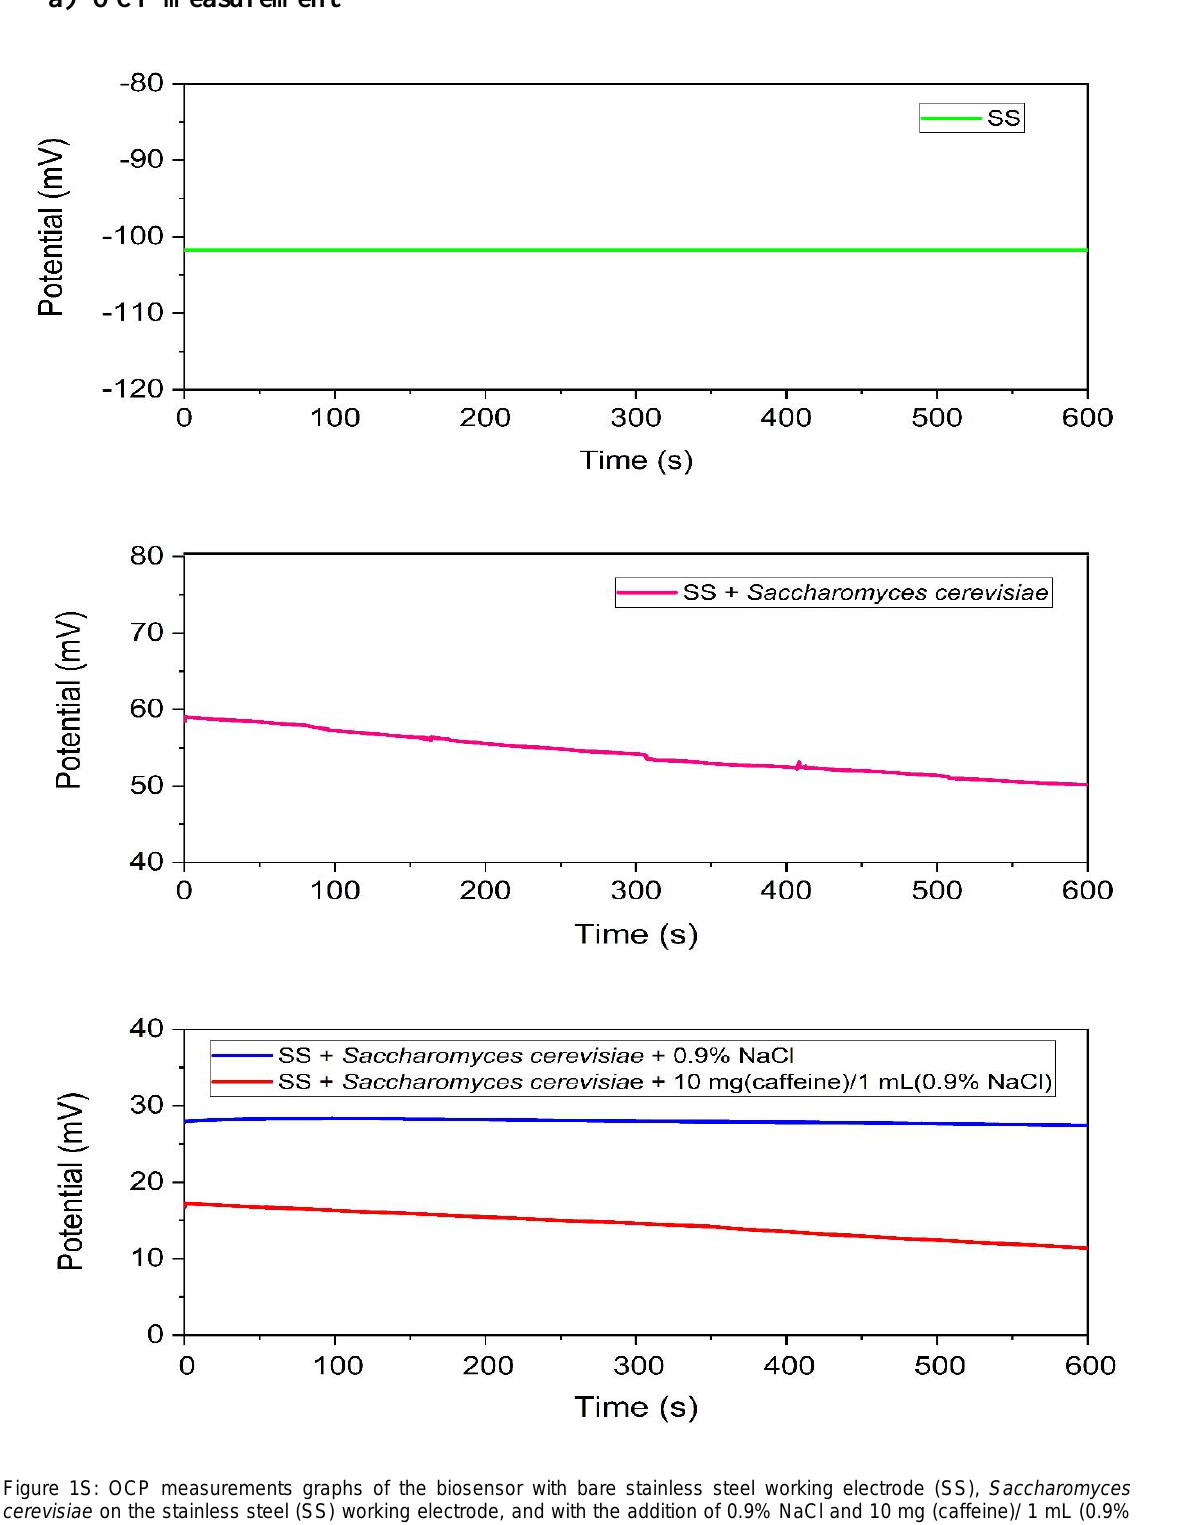
Figure 1S: OCP measurements graphs of the biosensor with bare stainless steel working electrode (SS), Saccharomyces cerevisiae on the stainless steel (SS) working electrode, and with the addition of 0.9% NaCl and 10 mg (caffeine)/ 1 mL (0.9% NaCl) to the biosensor containing stainless steel (SS) working electrode and Saccharomyces cerevisiae on the electrode